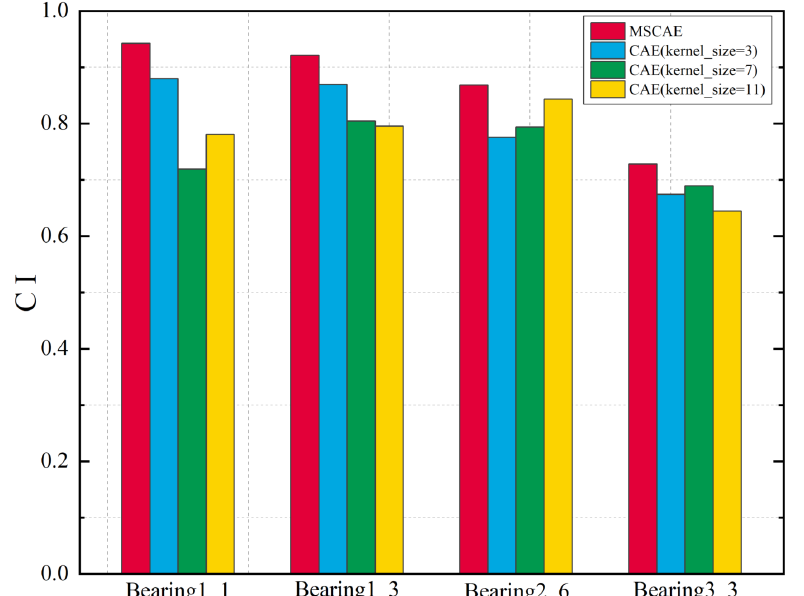
Figure 10. The HI of four testing bearings.